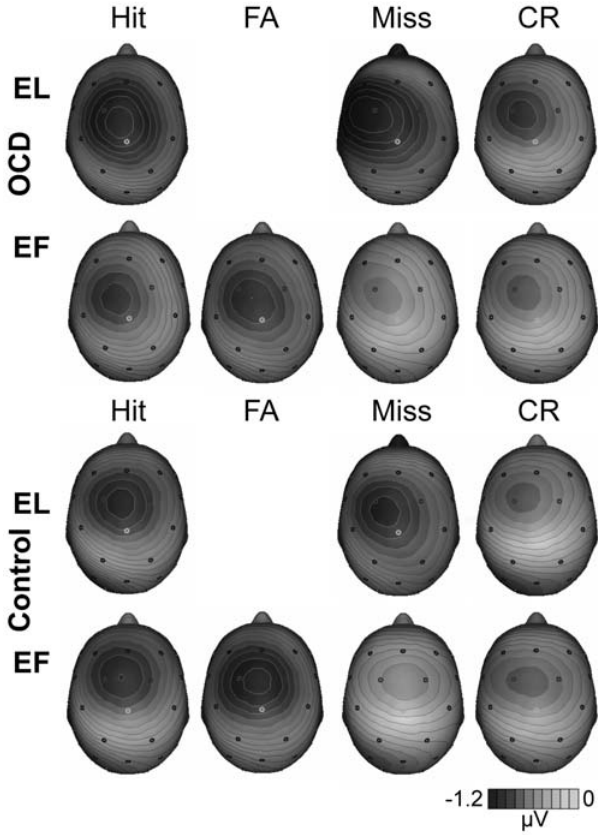
Figure 2. Topographical distributions of the brain potentials. Spline-interpolated isovoltage maps at 60 ms reveal a fronto-central distribution of the brain potentials. Darkest color is most negative.